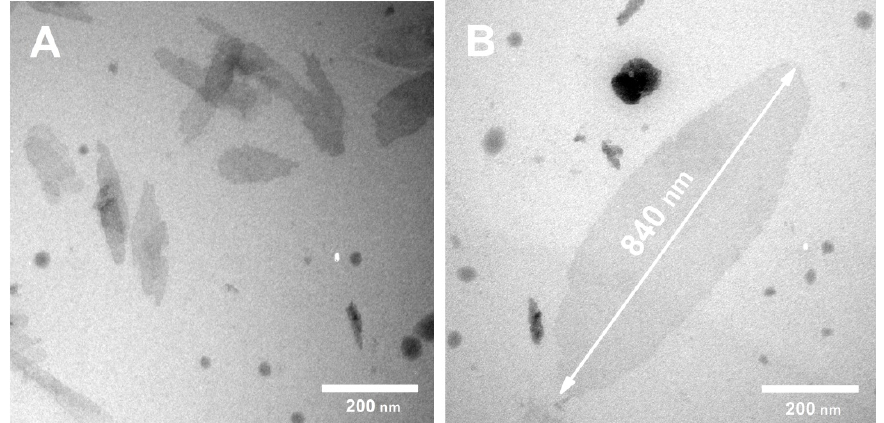
Figure 2. TEM-images of graphene particles, stabilized with PVP ( A ) and Plu ( B ). The particles of different sizes were obtained depending on the type of stabilizer and the duration of ultrasonic treatment. The duration of ultrasonic treatment of Plu-stabilized dispersions is 1–2 h, in case of PVP-stabilized it was 2–4 h.